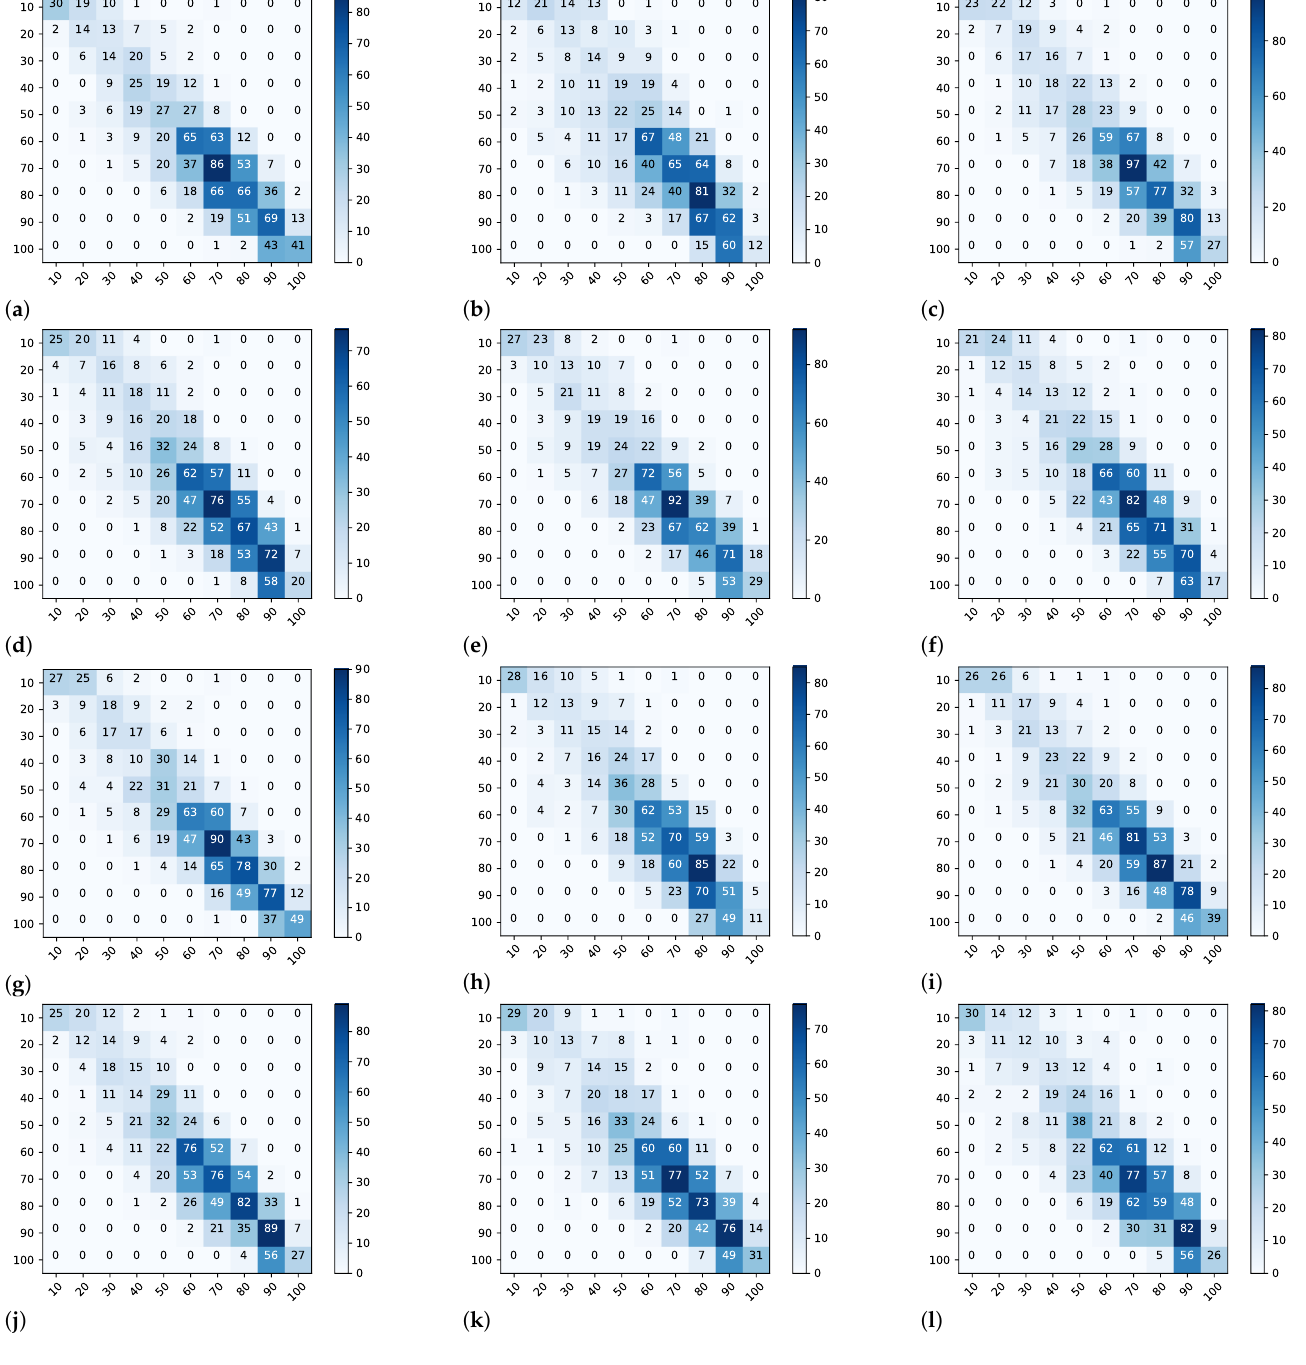
Figure 6. Confusion Matrix plot. The values in the matrices represent the sum of the prediction from all 10 test sets in the 10-fold cross-validation procedure. The lines represent the ground-truth label, and the columns represent the predicted label. ( a ) AlexNet pretrained. ( b ) AlexNet not pretrained. ( c ) ResNet18 pretrained. ( d ) ResNet18 not pretrained. ( e ) ResNet34 pretrained. ( f ) ResNet34 not pretrained. ( g ) ResNet50 pretrained. ( h ) ResNet50 not pretrained. ( i ) ResNeXt101 pretrained. ( j ) ResNeXt101 not pretrained. ( k ) DarkNet pretrained. ( l ) DarkNet not